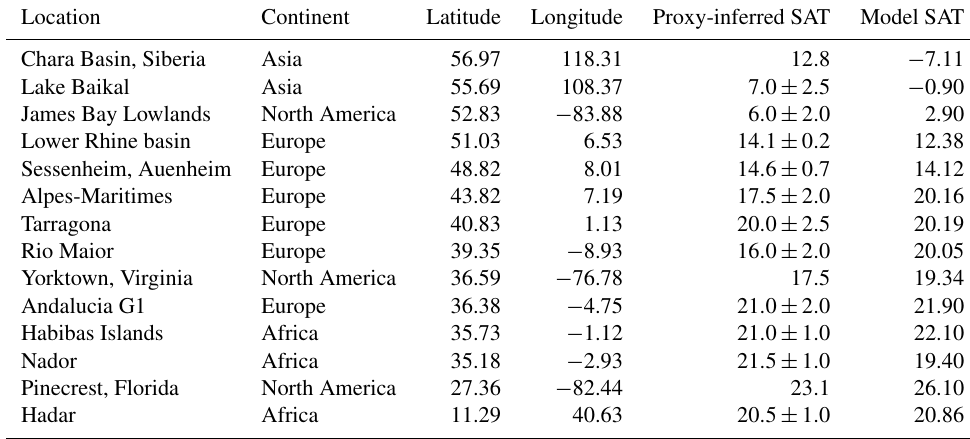
Table 4. Proxy reconstructed mid-Pliocene mean annual surface air temperatures (MASATs) during the PRISM3 interval (3.3–3.0 Mya) from Salzmann et al. (2013) compared to that simulated with our 400ppmv mid-Pliocene simulation E oi 400